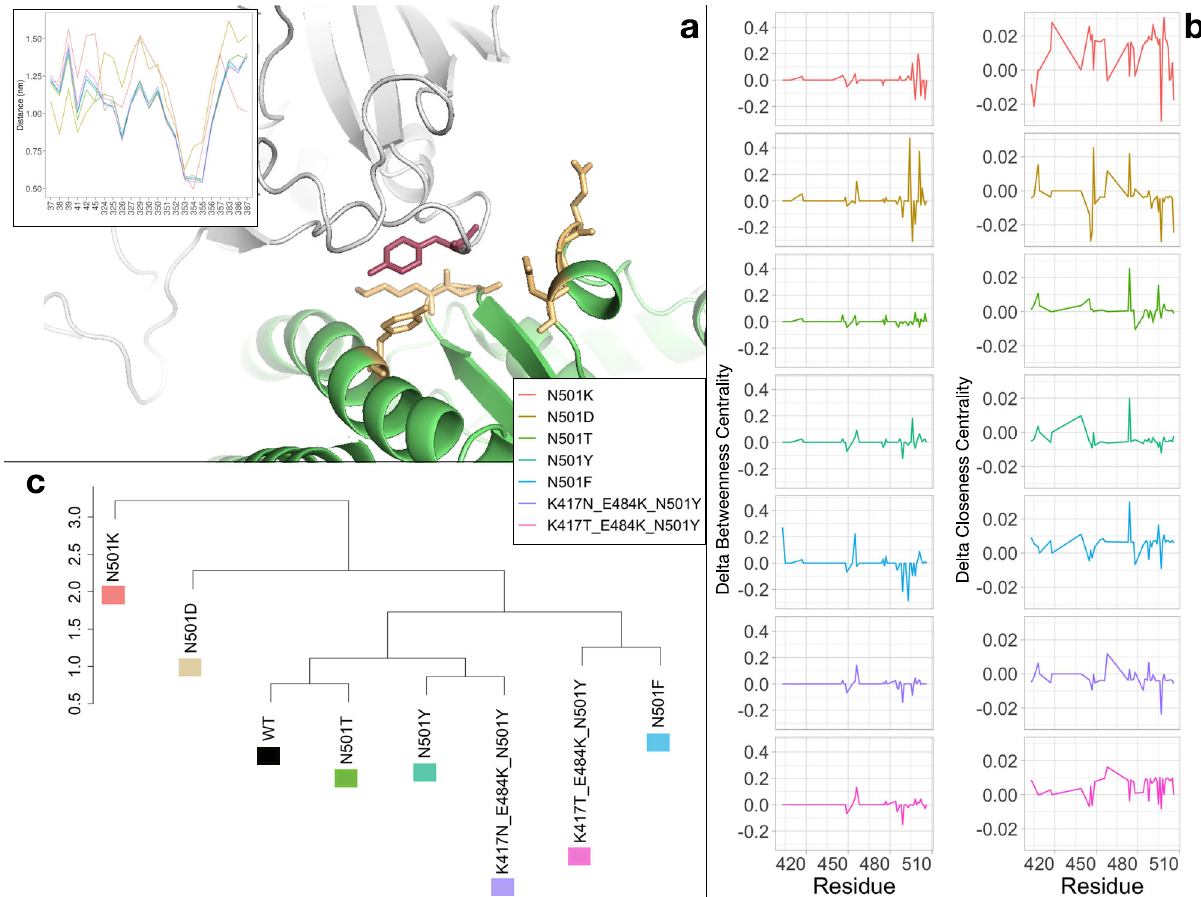
Fig. 5 Graph analysis of the interacting residues ’ network. a Cartoon representation of the complex (PDB id:6M0J) between SARS-CoV-2 spike protein (gray) and the human ACE2 receptor (green). Residue 501 of the spike protein is represented in red sticks, while a set of interacting residues of the ACE protein are identi fi ed in yellow sticks on the basis of a spatial distance threshold of 9 Å . The inset shows the average minimum distance of the ACE2 interacting residues with residue 501 of the spike protein for each variant. b Difference in Betweenness (left column) and Closeness (right column) centrality of each node of the SARS-CoV-2 spike found in interaction with ACE2 receptor between the seven studied spike variants and the WT one (see Table 1). c Hierarchical clustering of the seven spike variants together with the WT reference one (see Table